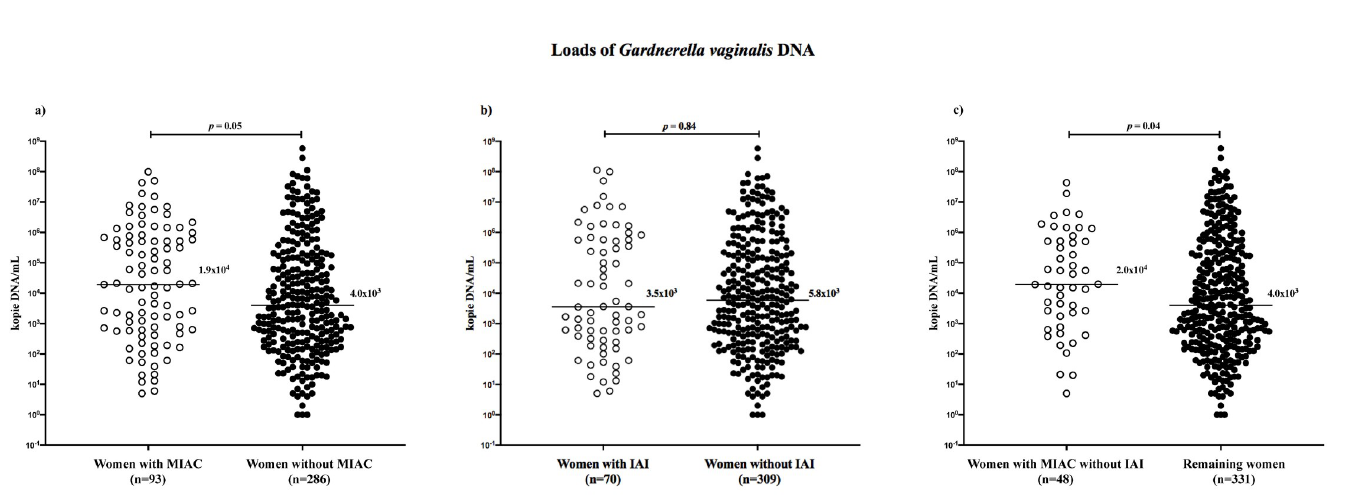
Fig 2. Microbial loads of G . vaginalis DNA in women with preterm prelabor rupture of the membranes with the cervical presence of G . vaginalis DNA with respect to microbial invasion of the amniotic cavity (a), intra-amniotic inflammation (b), and microbial invasion of the amniotic cavity without intra-amniotic inflammation (c).